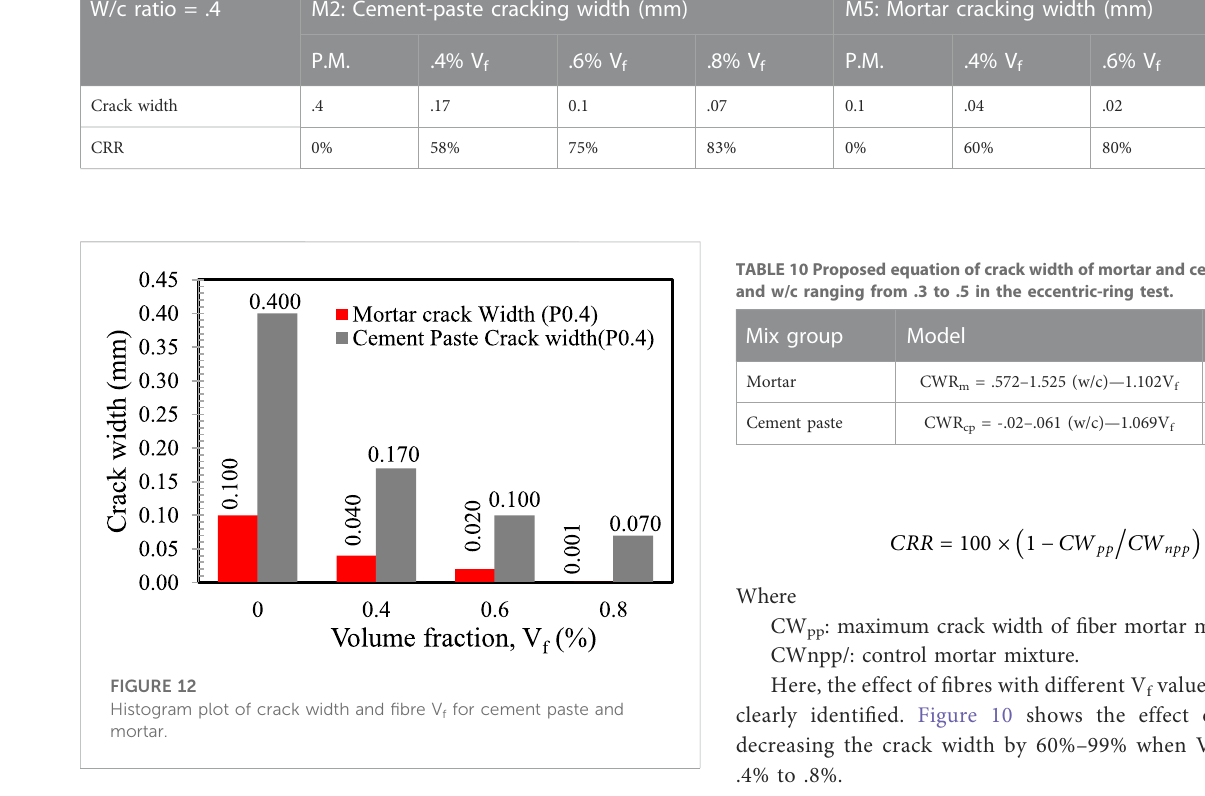
TABLE 9 Comparison between cement-paste cracking width and mortar cracking width with equal w/c ratios. W/c ratio = .4